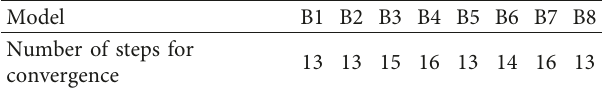
Table 1: Number of steps for each model. Model